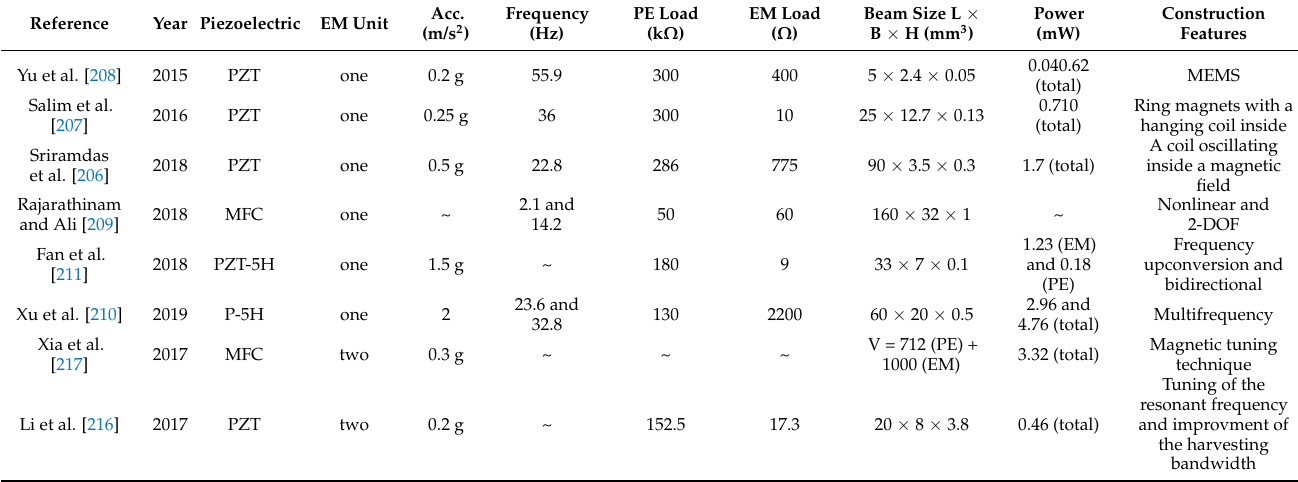
Table 5. Performances of some reported hybrid piezoelectric–electromagnetic